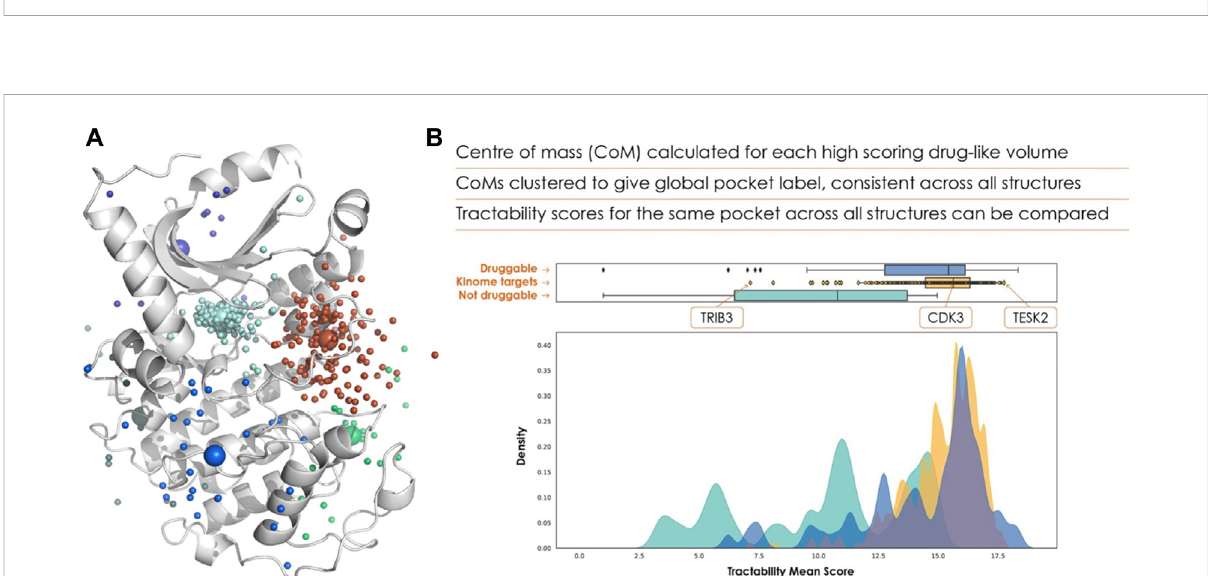
FIGURE 2 (A) ClusteredpocketsacrossallAlphaFold2structuresofthehumankinome,withtheAlphaFold2modelofcyclin-dependentkinase7(UniProt ID P50613). The cyan points show the ATP binding site of each kinase, allowing us to rank the kinome purely based on ATP-pocket druggability. (B) The frequency distribution of ATP site scores is shown in yellow, with known druggable (blue) and non-druggable (green) targets for